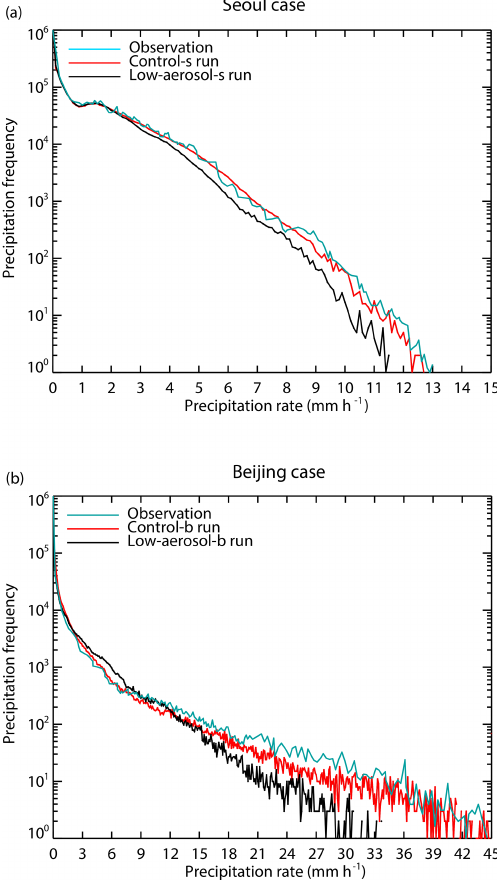
Figure 4. Observed and simulated cumulative frequency distribu- tions of precipitation rates at the surface for (a) the Seoul case, which are collected over the Seoul area, and (b) the Beijing case, which are collected over the Beijing area, at the last time step. Sim- ulated distributions are in the control-s and low-aerosol-s runs for the Seoul case and in the control-b and low-aerosol-b runs for the Beijing case. The observed distribution is obtained by interpolat- ing and extrapolating the observed precipitation rates to grid points and time steps in the control-s and control-b runs for the Seoul and Beijing cases,